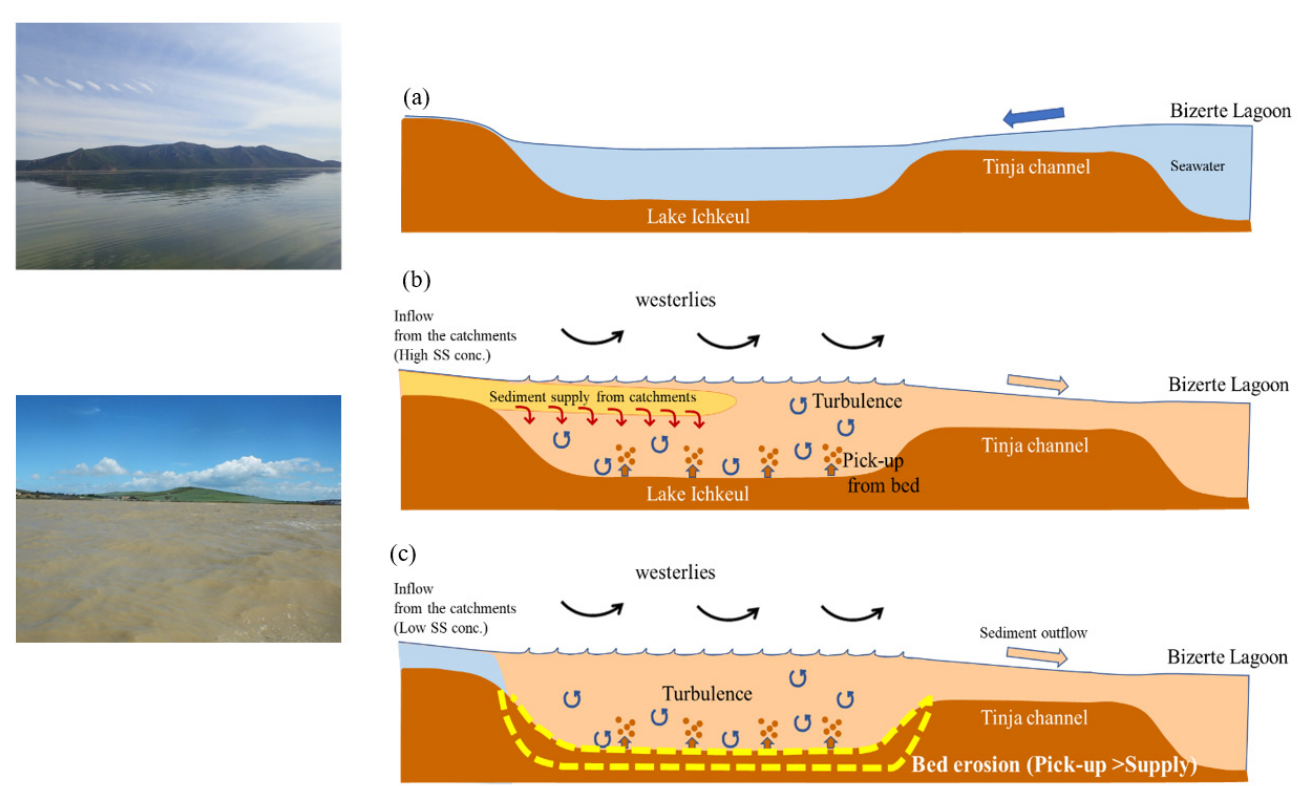
Figure 3. Schematic images of seawater intrusion and transportation of sediment in Ichkeul Lake and typical images of the water surface in summer and winter. ( a ) Dry season in summer (Lake < Lagoon: seawater intrusion). ( b ) Rainy season in winter (Lake > Lagoon: resuspension of bed material) without dams. ( c ) Rainy season in winter with dams (Sediment supply = 0).